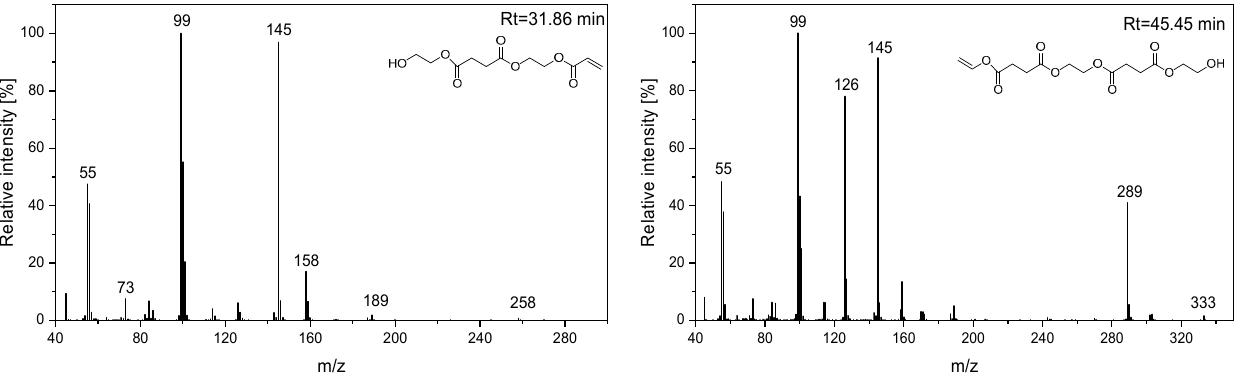
Figure 3. Mass spectra of major decomposition products of PESu. Table 4. Thermal decomposition products of P Β Su.